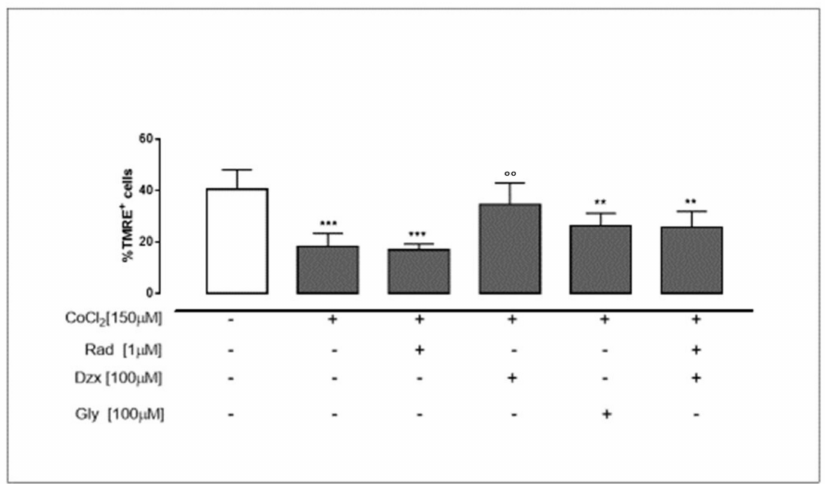
Figure 3. Mitochondrial Cx43 and the opening of mitochondrial K ATP channels prevent mitochondrial membrane depolarization. Cells were treated for 3 h with CoCl 2 (150 µ M); rad (1 µ M), dzx (100 µ M) and gly (100 µ M) were added 30 min before CoCl 2 administration. Flow cytometry analysis was carried out through tetramethylrhodamine ethyl ester (TMRE), a red–orange positive dye that